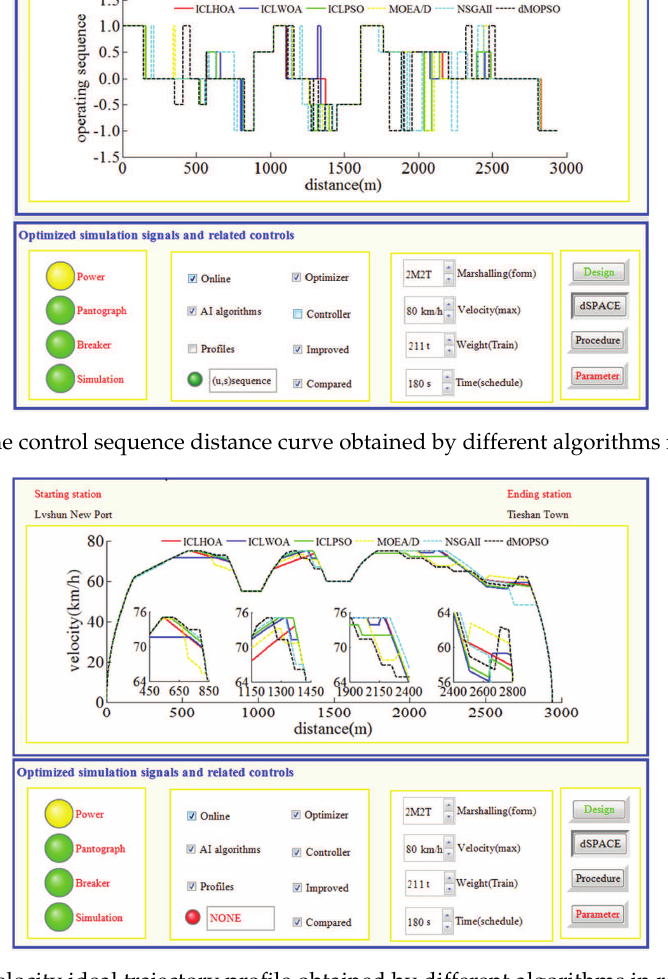
Figure 23. The velocity ideal trajectory profile obtained by different algorithms in retaining ‘control loop’ containing physical hardware devices